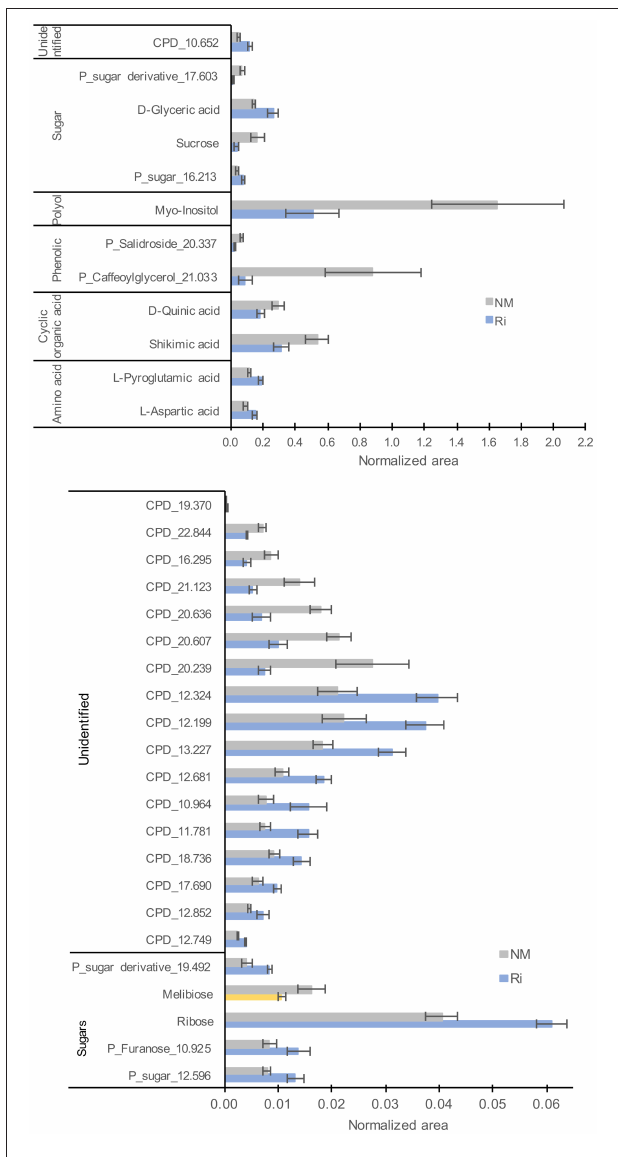
FIGURE 6 | GC-MS metabolites significantly altered by the mycorrhization in leaves. Contents are expressed as normalized areas for each metabolite. Data are the mean ± SE of 14 independent biological replicates for the NM condition and 11 for the Ri condition. Metabolites significantly different between NM and Ri conditions were identified with a fold change of at least + /– 1.5 and a p value < 0.05 (in blue) or a p value < 0.1 (in yellow, Wilcoxon